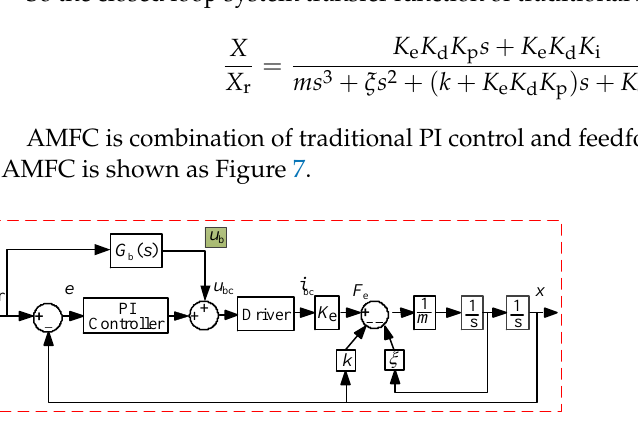
Figure 7. Combination of PI and feedforward